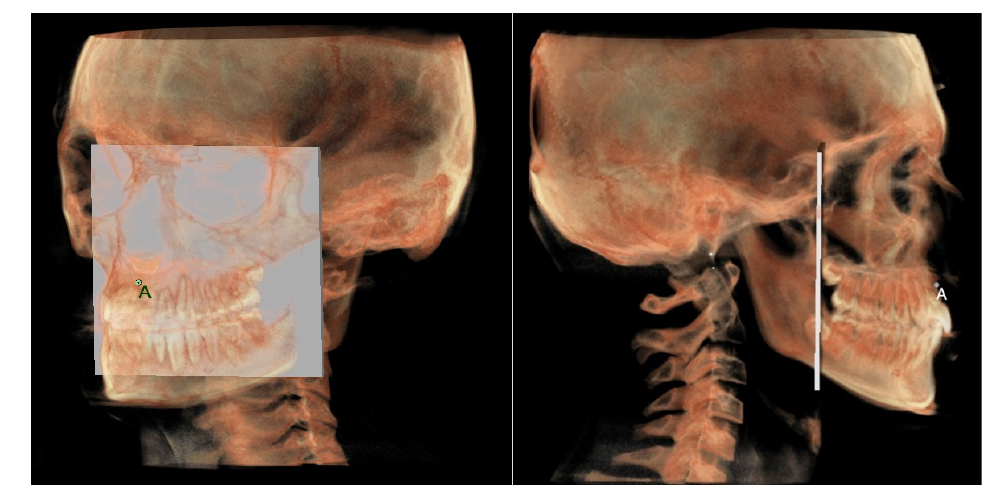
Figure 6. Maxillary skeletal arch in 3D analysis.